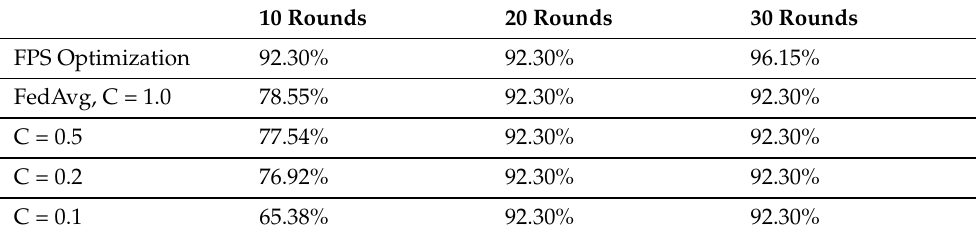
Figure 6. Comparison of the FPS Optimization and FedAvg Accuracy and Loss Results for the chest lesion caused by the COVID-19 infection dataset. Table 6. Test Accuracy of the